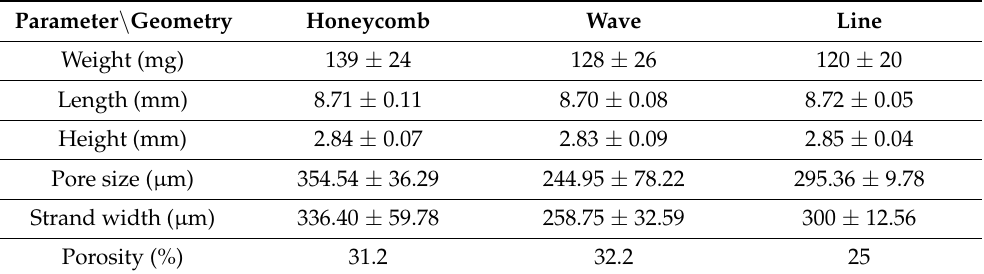
Figure 2. Comparison of square PCL scaffolds with different inner structures: ( a ): line; ( b ): wave; ( c ): honeycomb. Table 4. Dimensions and weight of the PCL scaffolds, with variations in inner geometry (starting from square